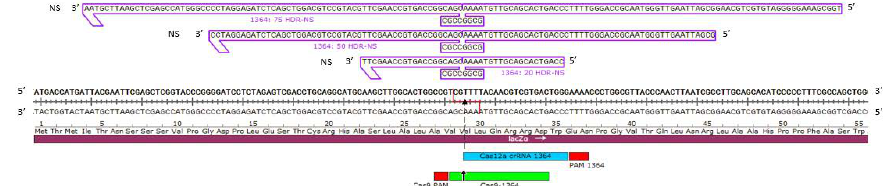
Figure 1. CRISPR / Cas12a / Cas9 target sites on the LacZ α gene with various lengths of symmetrical HDR-NS oligonucleotides. The lacZ α gene is shown with overlapping cleavage sites for CRISPR / Cas12a and CRISPR / Cas9. The staggered 5 (cid:48) , five base overhangs are generated by a Cas12a RNP and illustrated with a staggered red line while a Cas9 RNP generates a blunt ended cut shown by a dotted black arrow. Above the target sites are three oligonucleotides (denoted as the NS-strand in a 3 (cid:48) –5 (cid:48) direction) with symmetrical homology arms of di ff erent lengths flanking an eight base NOTI site in the